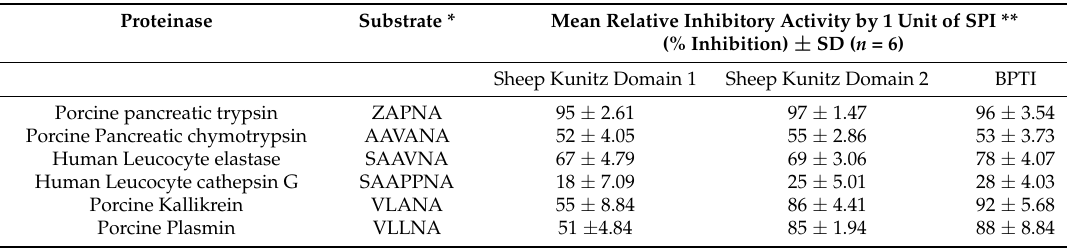
Table 1. Serine proteinase inhibitory (SPI) activities of the Bikunin Kunitz protease inhibitor (KPI) domains and bovine pancreatic trypsin inhibitor (BPTI).